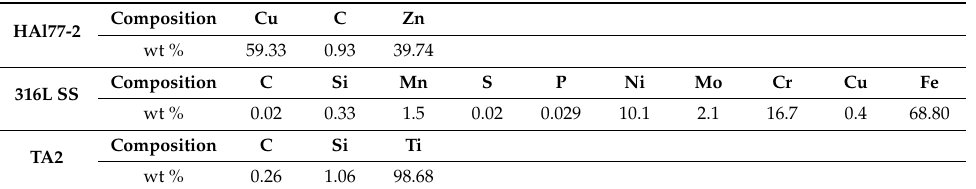
Table 1. Composition of HAl77-2, 316L SS, and TA2.